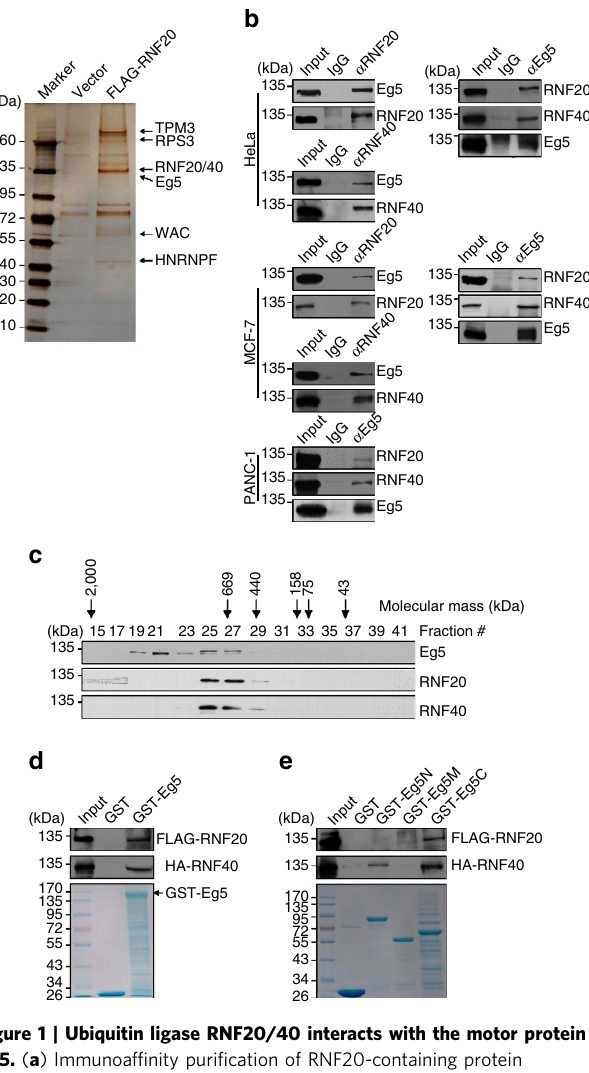
NATURE COMMUNICATIONS|7:12648|DOI: